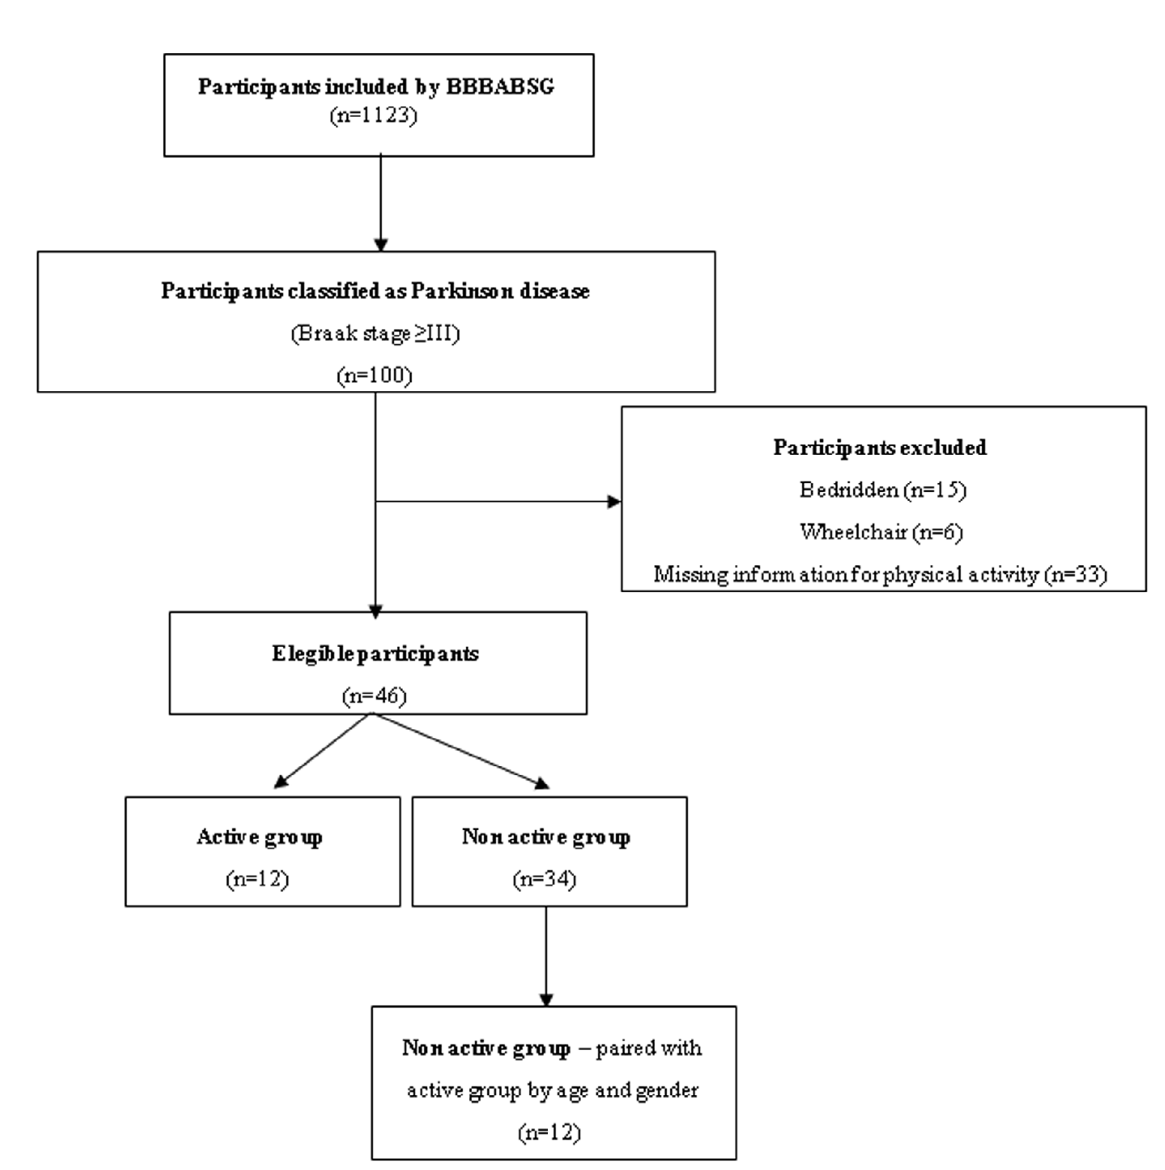
Figure 1. Flowchart of the inclusion process of the study